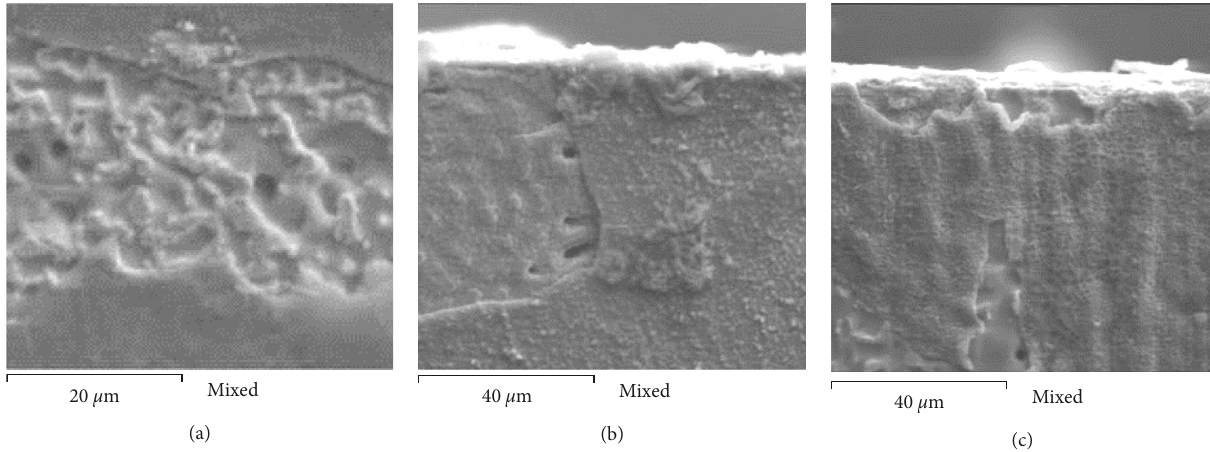
Figure 15: Cavities formed due to diffusion of Al during the oxidation process of the Ni